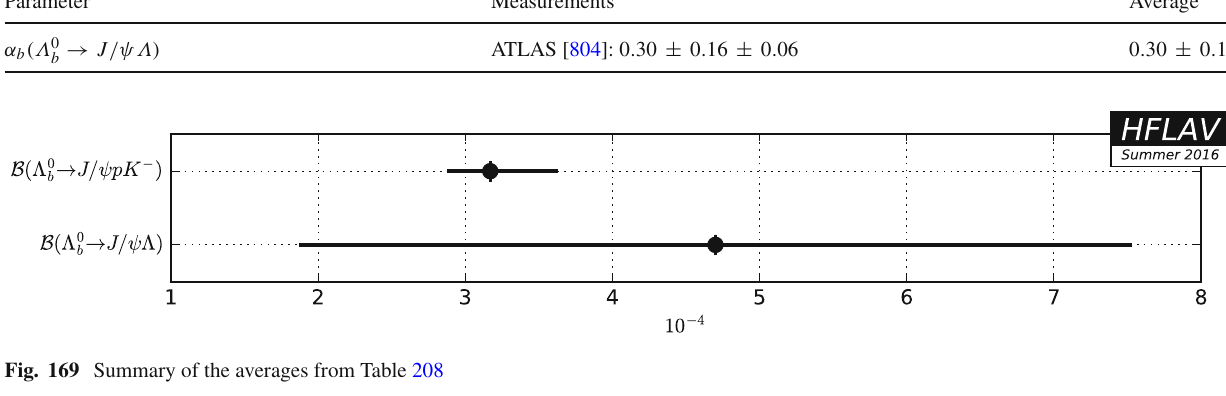
Fig. 169 Summary of the averages from Table